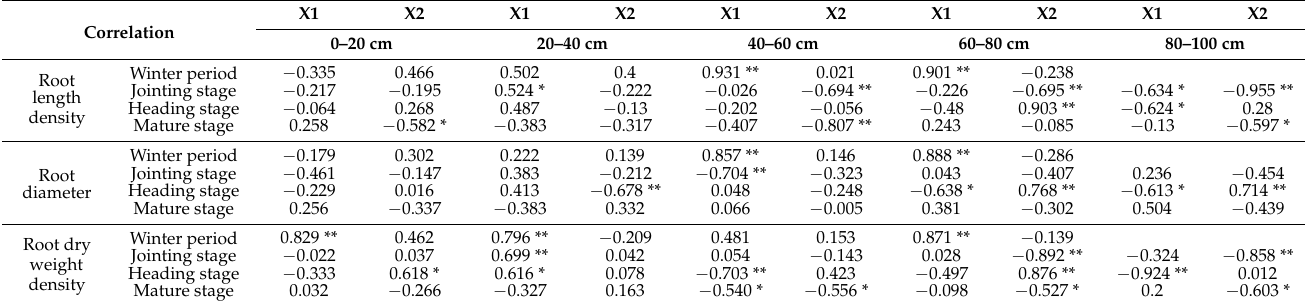
Table 2. Correlation analysis between root index and yield of different winter wheat varieties at different growth